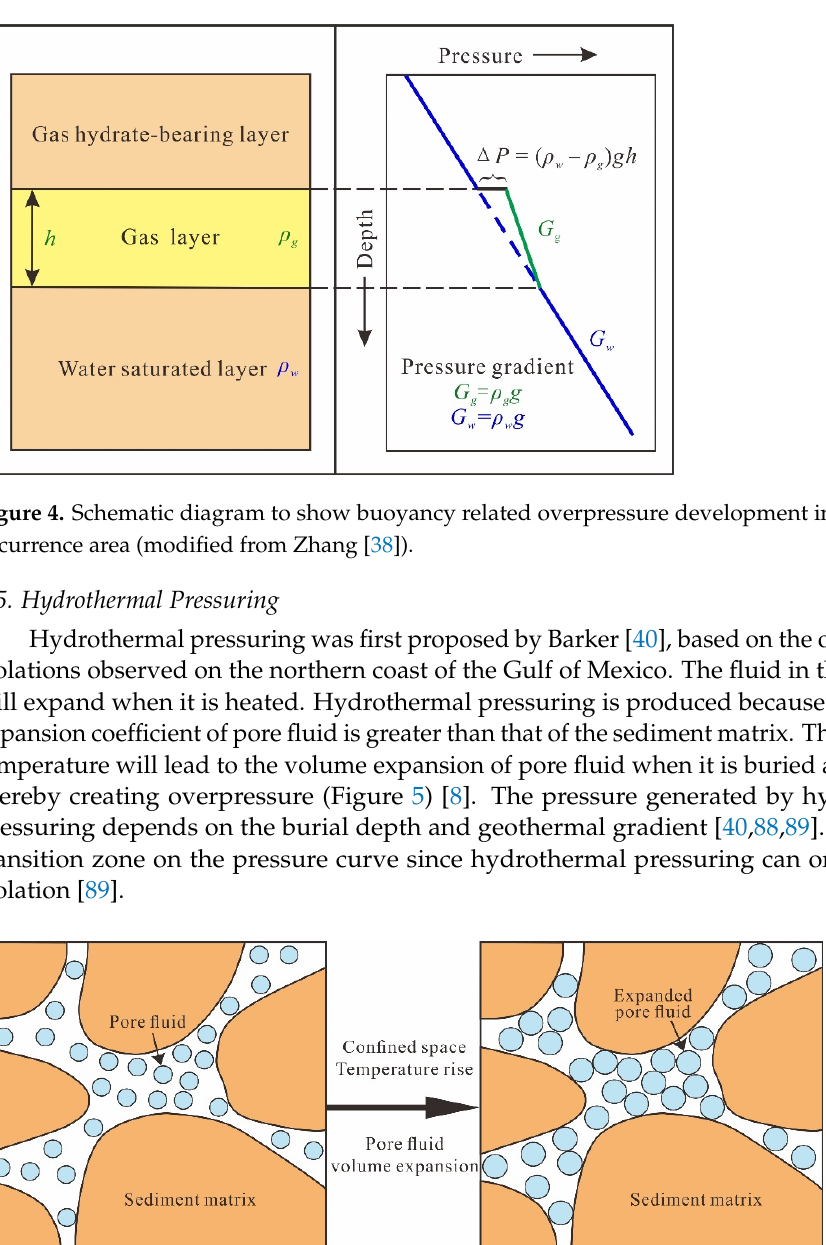
Figure 4. Schematic diagram to show buoyancy related overpressure development in gas hydrate occurrence area (modified from Zhang [38]).